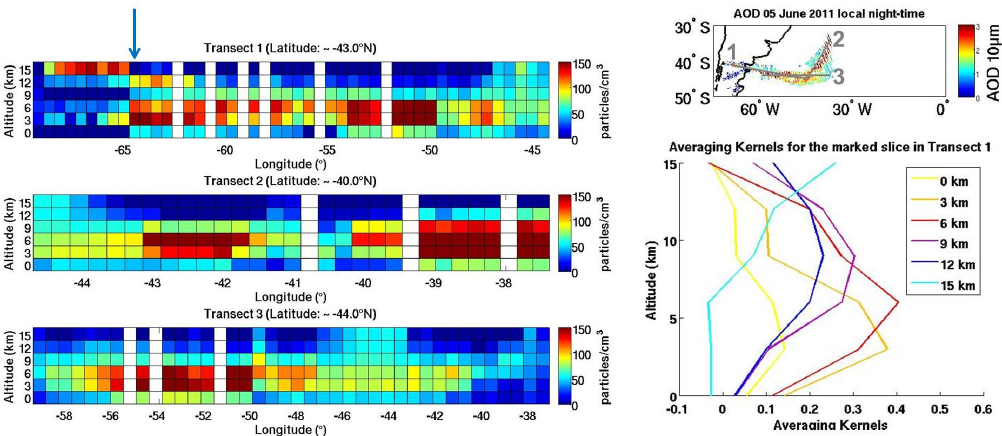
Figure 8. Transects across different parts of the ash plume on 5 June 2011, local evening. The map at the top right shows the corresponding AOD map with the three transect locations. Averaging kernels are also shown for the IASI profile marked with a blue arrow in the first transect, for each retrieval altitude. The number of DOF for this scene was